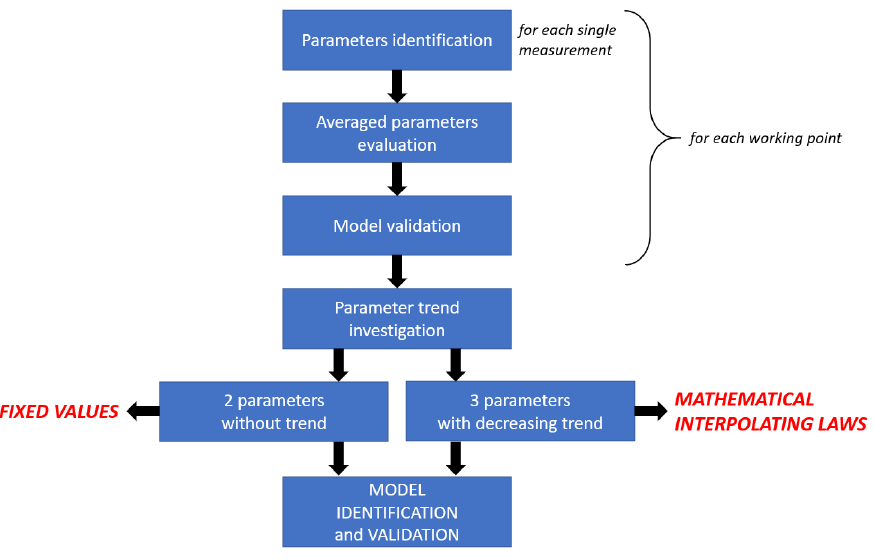
Figure 14. Second approach